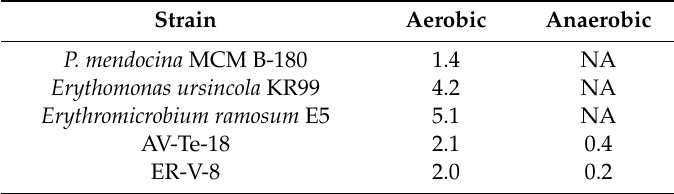
Table 1. Amount of tellurite, removed (mg / L / h) under aerobic and anaerobic conditions for P.